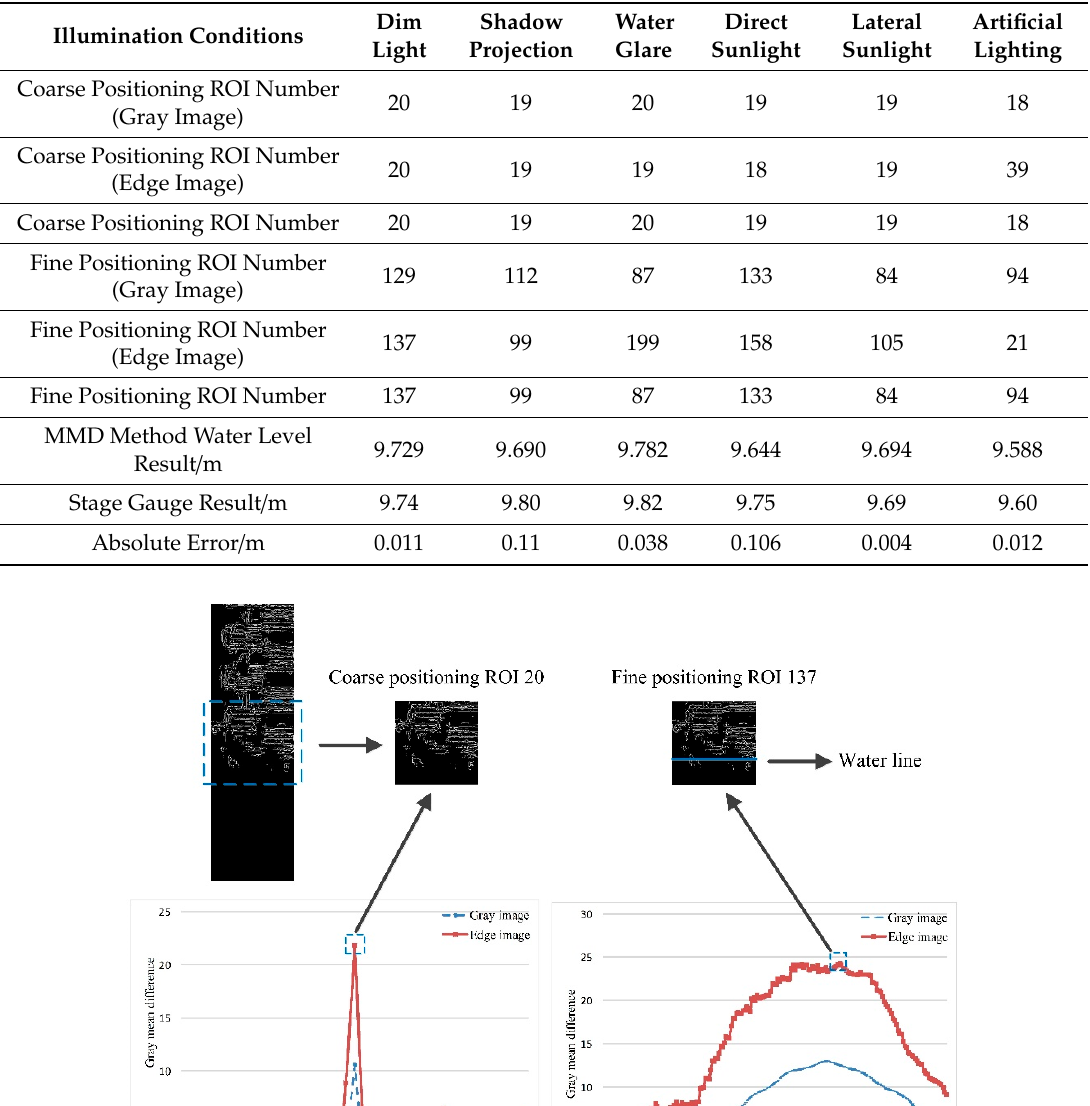
Table 3. ROI and water-level results of the MMD method under di ff erent illumination conditions.